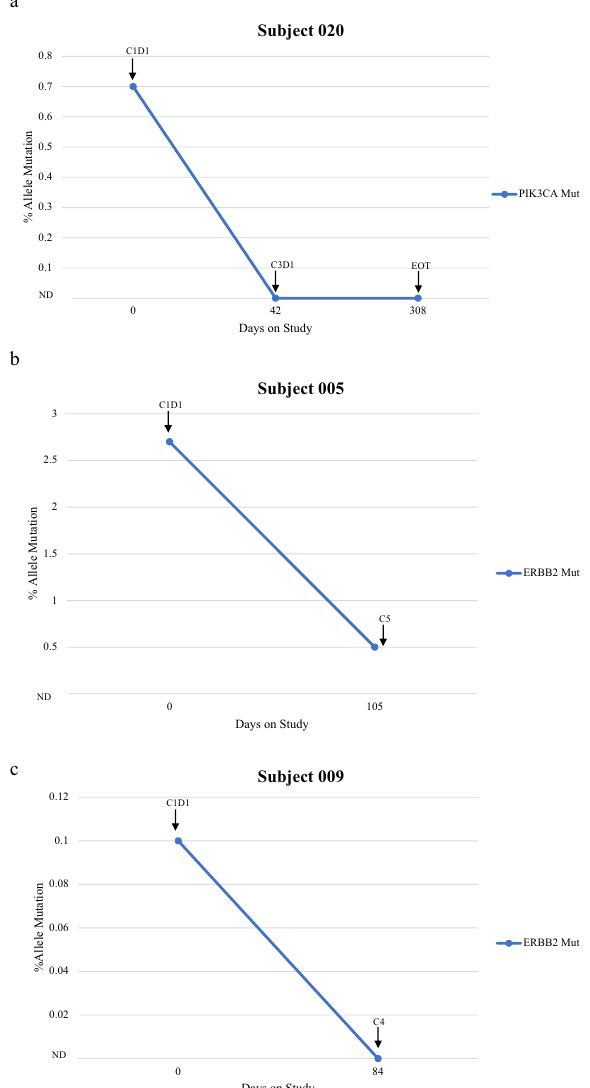
Fig. 3 Select circulating tumor DNA (ctDNA) results. a Subject 020 ctDNA results. C cycle, D day, ND not detected, EOT end of treatment, Mut mutation. b Subject 005 ctDNA results. C cycle, D day, ND, not detected, Mut mutation. c Subject 009 ctDNA results. C cycle, D day, ND not detected, Mut